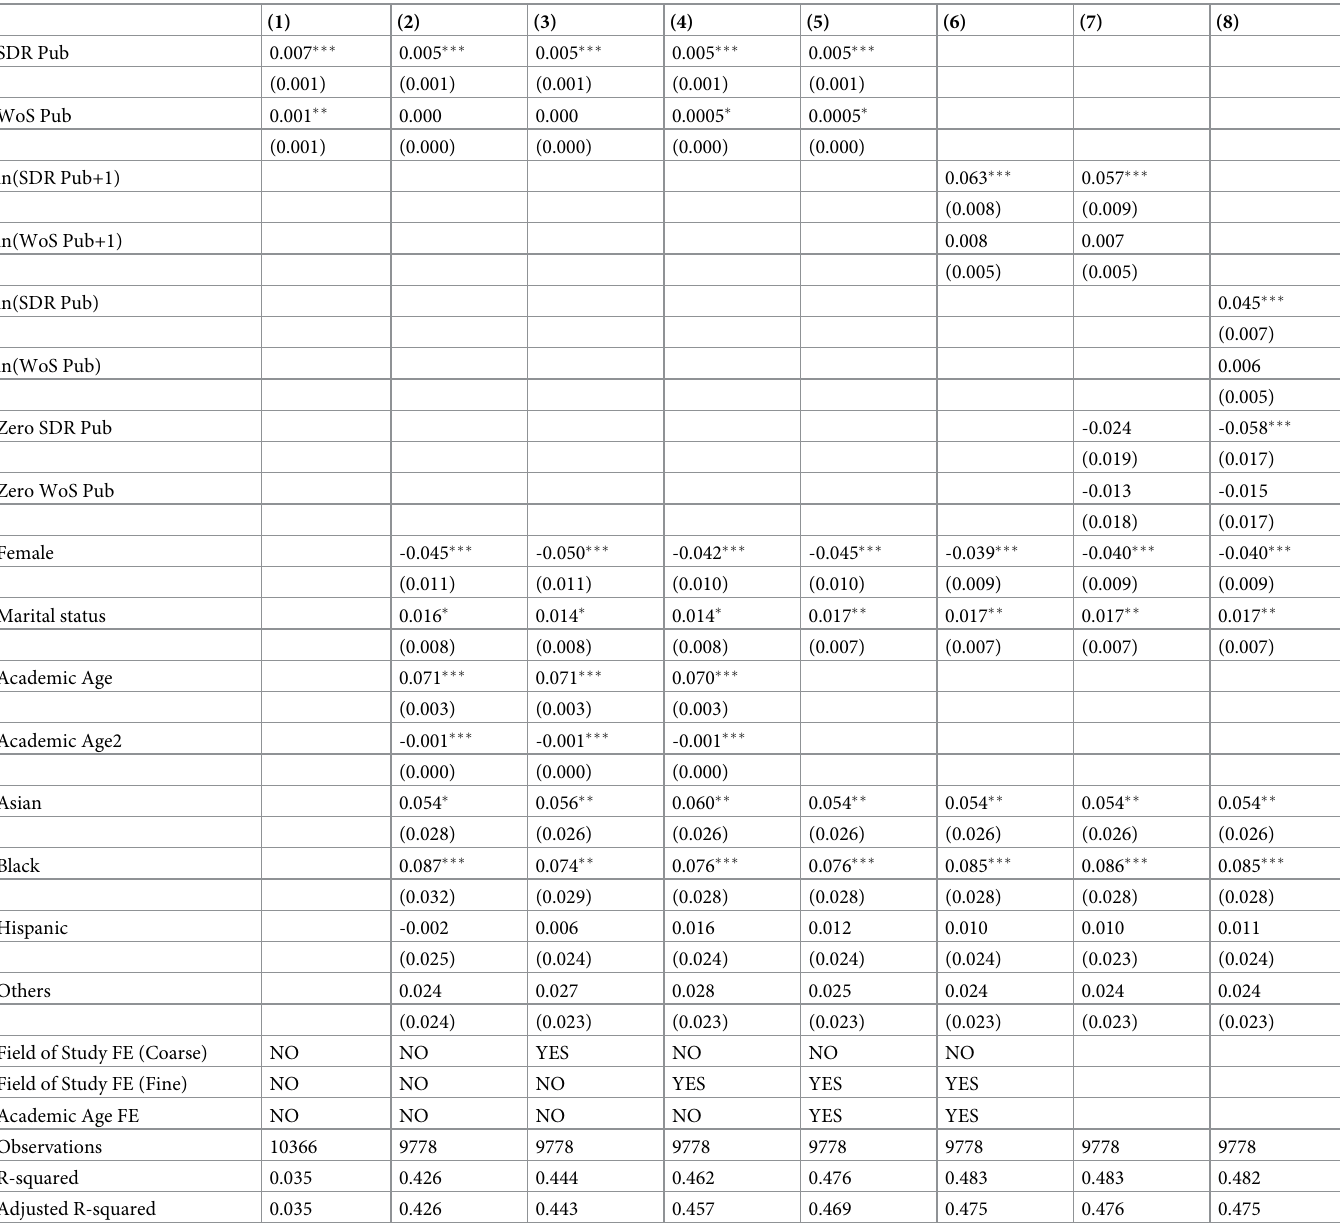
Table 3. Horse race comparisons of SDR and WoS publication counts as determinants of tenure